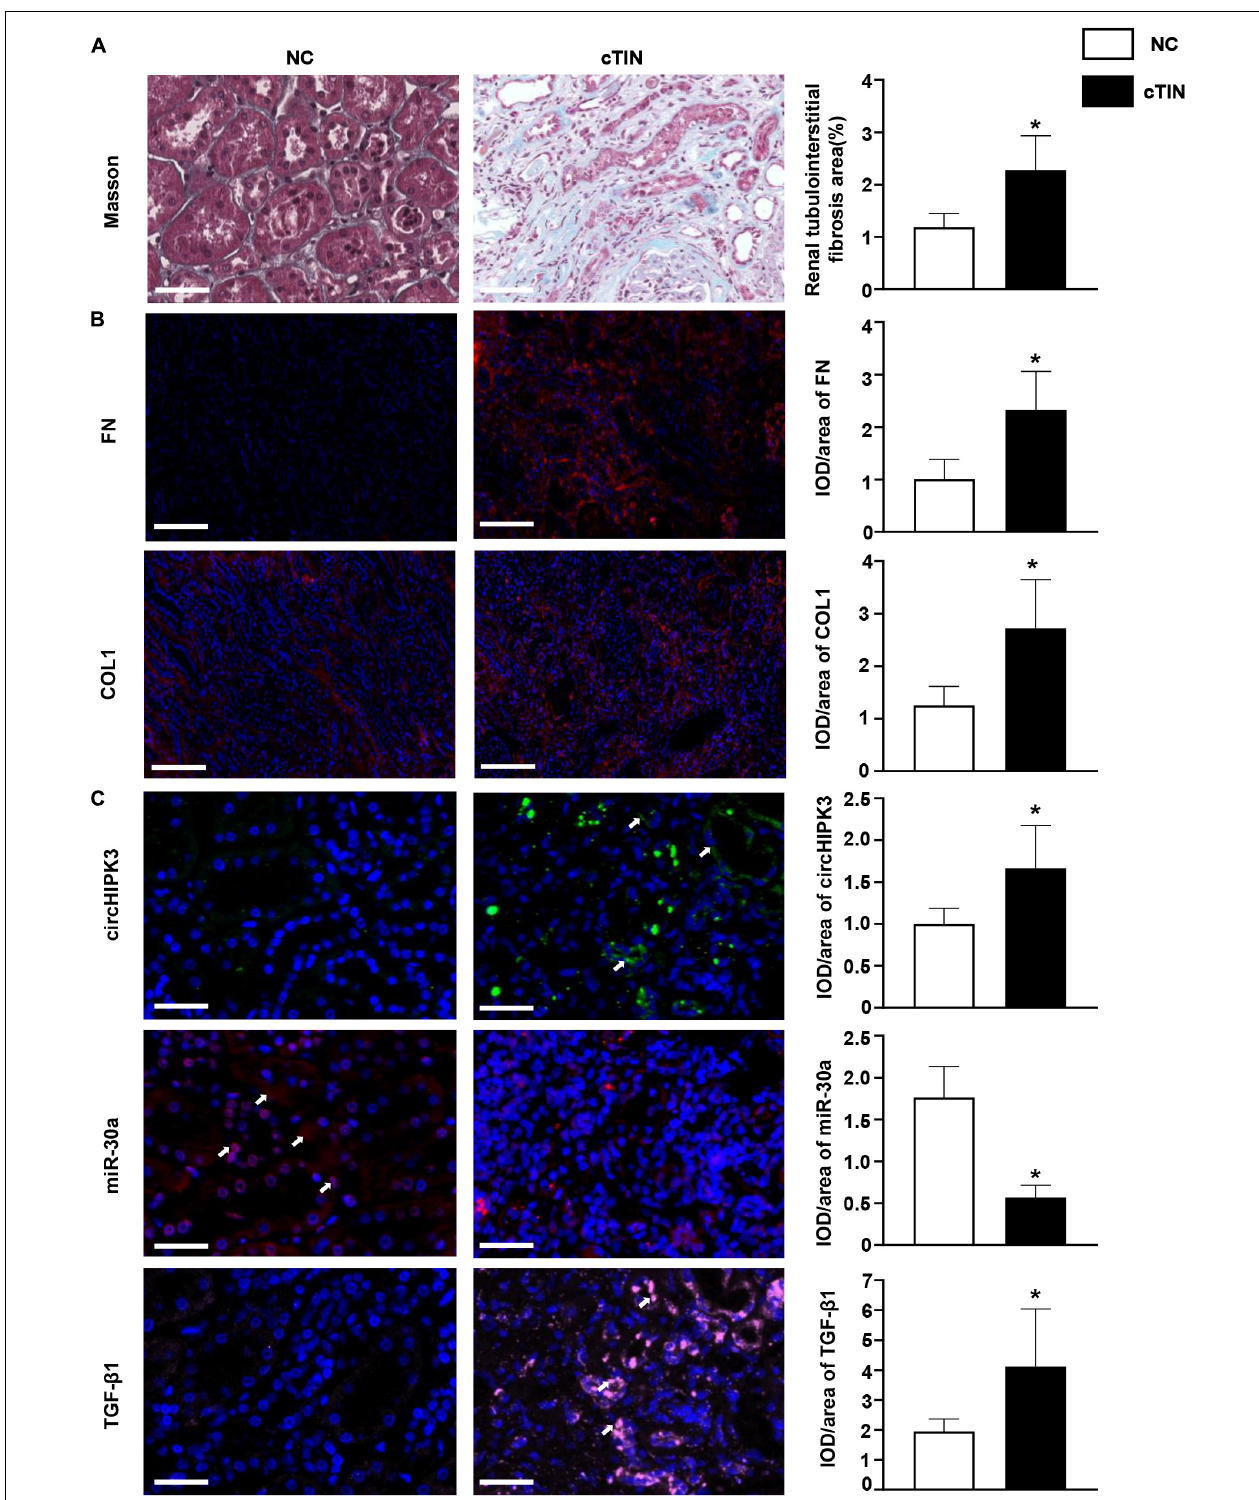
FIGURE 5 | Renal expression of circHIPK3 in patients with chronic tubulointerstitial nephritis (cTIN). (A) Masson staining of kidney. (B) Expression of FN and COL1 shown by immunofluorescence staining. (C) Expression of circHIPK3, miR-30a, and TGF- β 1 on FISH and immunofluorescence staining. Magnification 200 × , bar scale: 50 µ m. n = 3 in each group, * p < 0.05, cTIN vs. NC.